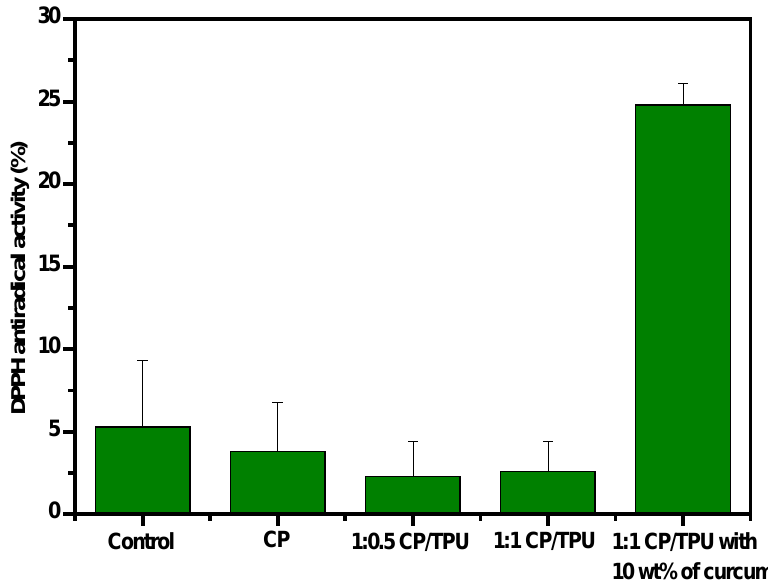
Figure 8. DPPH radical scavenging activity of composites.